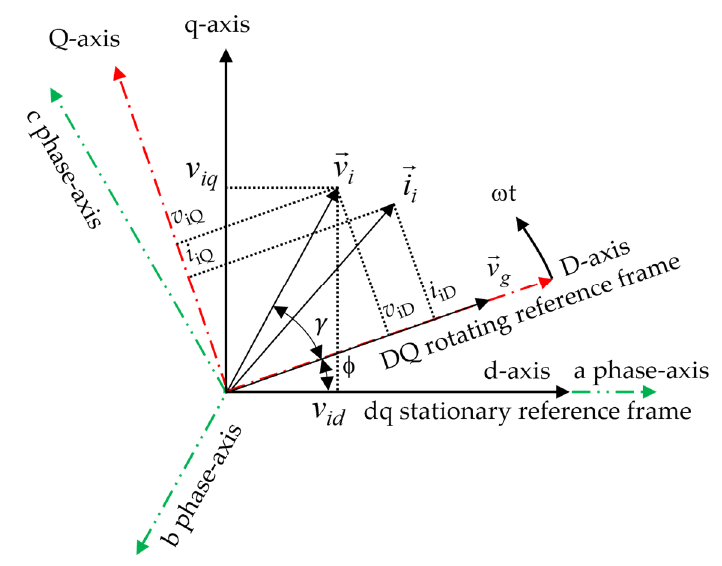
Figure 5. Space vector diagram for grid connection and active power control.